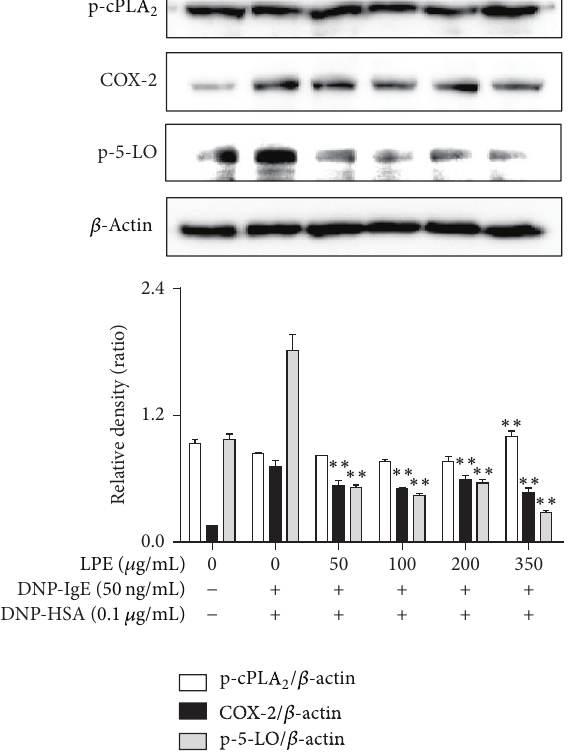
Figure 4: Effect of LPE on phosphorylation or expression of rate- limiting enzymes in the arachidonate cascade. RBL-2H3 cells were seeded on a 6-well plate (5 × 10 5 cells/well) in MEM- 𝛼 with 10% FBS at 37 ∘ C overnight and further incubated with DNP-IgE for 24 h. IgE-sensitized RBL-2H3 cells were preincubated with LPE (0 to 350 𝜇 g/mL) prior to antigen challenge. The above cells were washed with 1x DPBS and lysed with cell lysis buffer. The expression of p- cPLA 2 , p-5-LO, COX-2, or 𝛽 -actin was determined as described in Section 2. Similar results were obtained in three independent experiments. ∗∗ 𝑃 < 0.01 versus DNP-HSA-treated